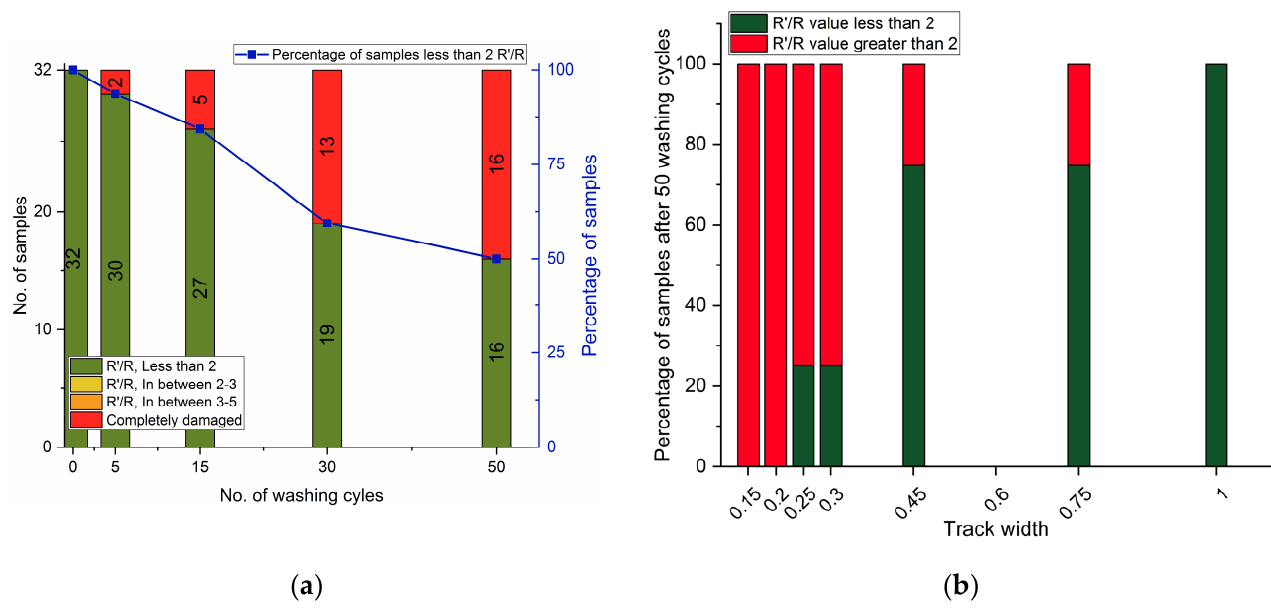
Figure 7. FPCB sample (without any protection) analyses after 50 Silk washing cycles, a total of 32 samples were tested: ( a ) No. of samples with R’/R values increased above 2, 3, and ultimately damaged pieces on the left y-axis and percentage of samples having R’/R value below 2 on the right y-axis; ( b ) ratio of samples having R’/R values below and above 2 after complete washing cycles based on track